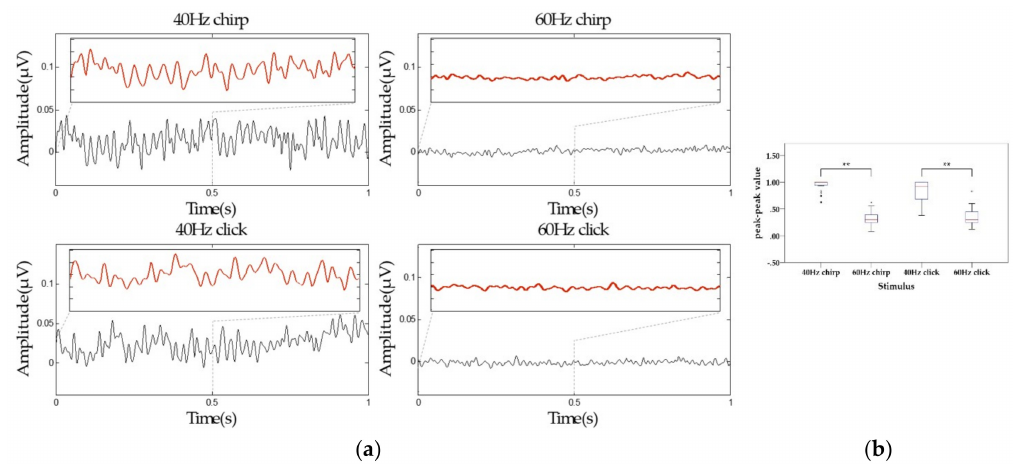
Figure 4. Mean time-domain waveforms of auditory steady-state responses (ASSRs) for 20 healthy subjects under selected leads: ( a ) Mean ASSR amplitude: the black line represents ASSR amplitude within 1s after stimulus, and the red line represents ASSR amplitude within 0.5 s after stimulus; ( b ) The boxplot of mean ASSR peak-peak value: the red line represents the median; (cid:4) and ◦ represent outliers; ** represents p ≤ 0.01.